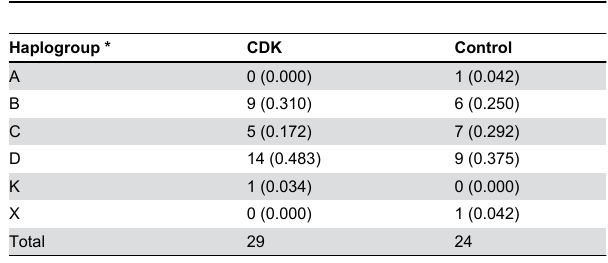
Table 1. mtDNA haplogroup frequencies of Mapuche CDK patients and controls.